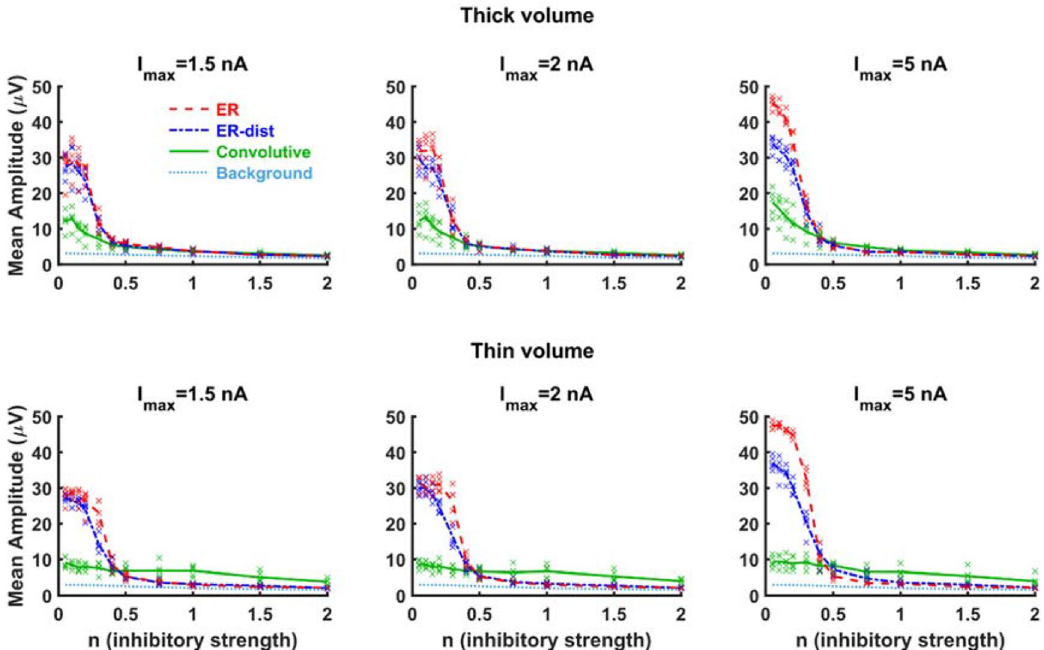
Figure 5. Realistic connectivity robustly protects from the consequences of strong inputs. Average membrane potential of the different models calculated, as a function of the inhibition, over the 10 s duration of an external input of different maximum strengths, I max . For any given value of I max and n , symbols represent the average membrane potential obtained from five network instances. Lines represent their average